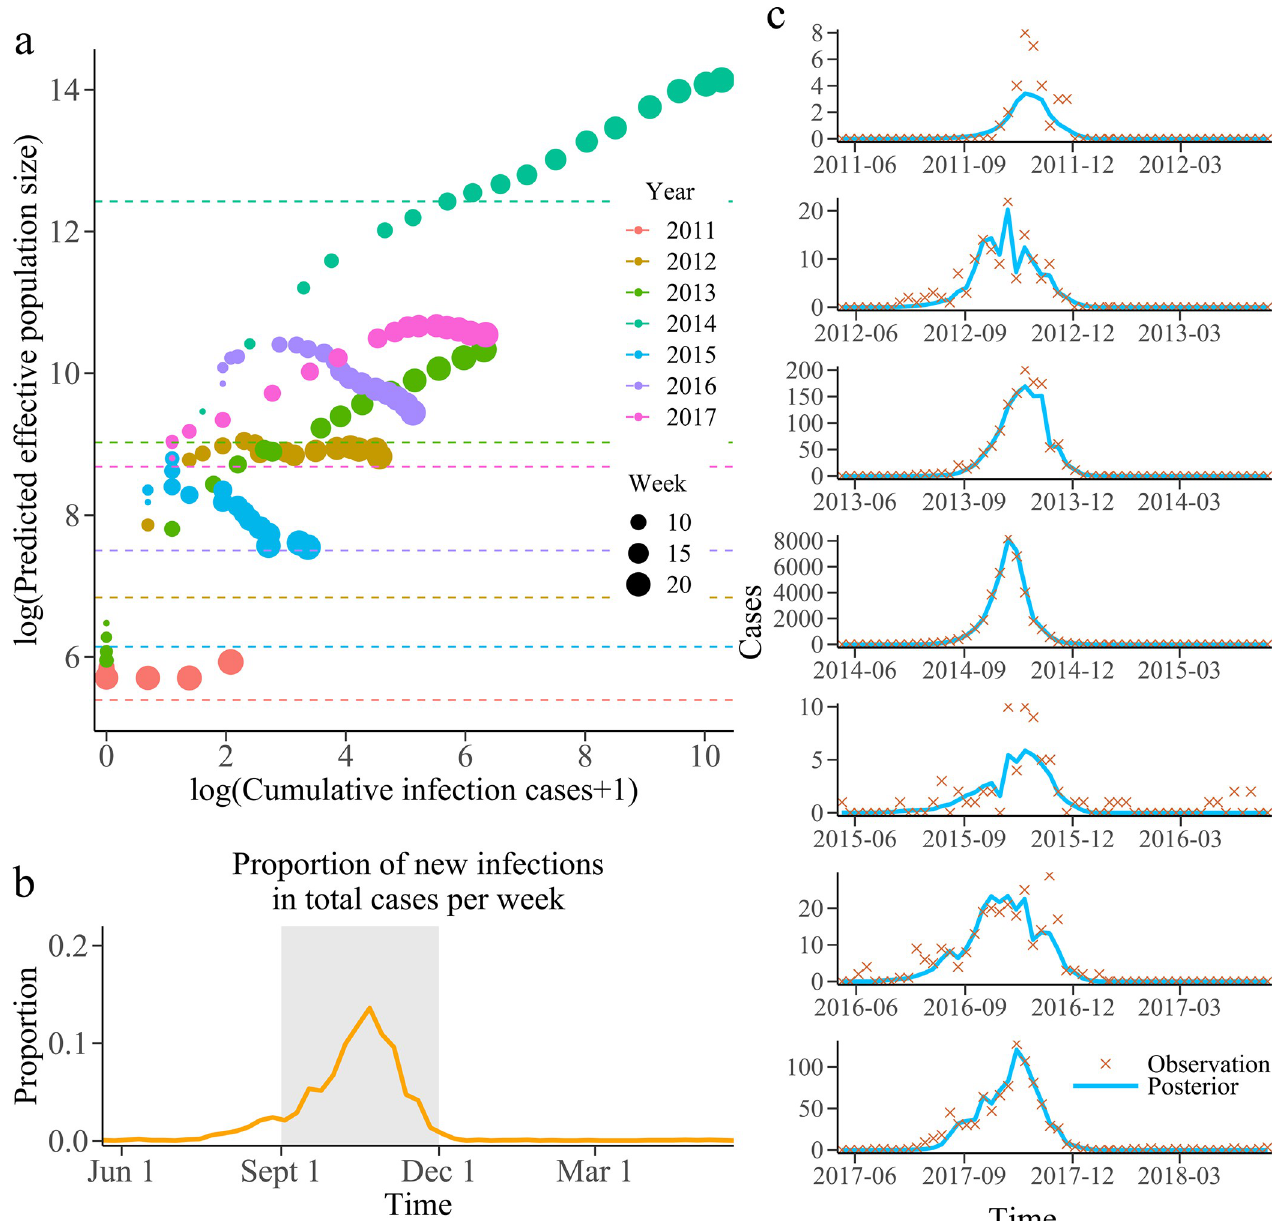
Fig 5. Prediction of population size and its function. a The population size set within the 5th and 22nd (the average peak time) weeks of each season. Each color represents corresponding year and the circle size indicate the predicted week. The dotted lines represents log(cumulative dengue cases over the corresponding season). The abscissa is log(cumulative infection number from the beginning of the dengue season to the current week +1). Besides, the ordinate is log(predicted population size). Based on the cumulative infection number from the beginning of the season to the current week, the total infection number was estimated as the population size of SIR-EAKF. For the convenience of display, log exchange was performed here. b Average proportion of new infections in total cases per week. The grey area shown that these 13 weeks (from 15 to 28 week) contain 90.7% of the total cases in the whole season except 2014–2015 season. c Weekly observed human dengue cases (cross symbols) for each year. The solid blue lines are the posterior mean of the combined SIR-EAKF fit.